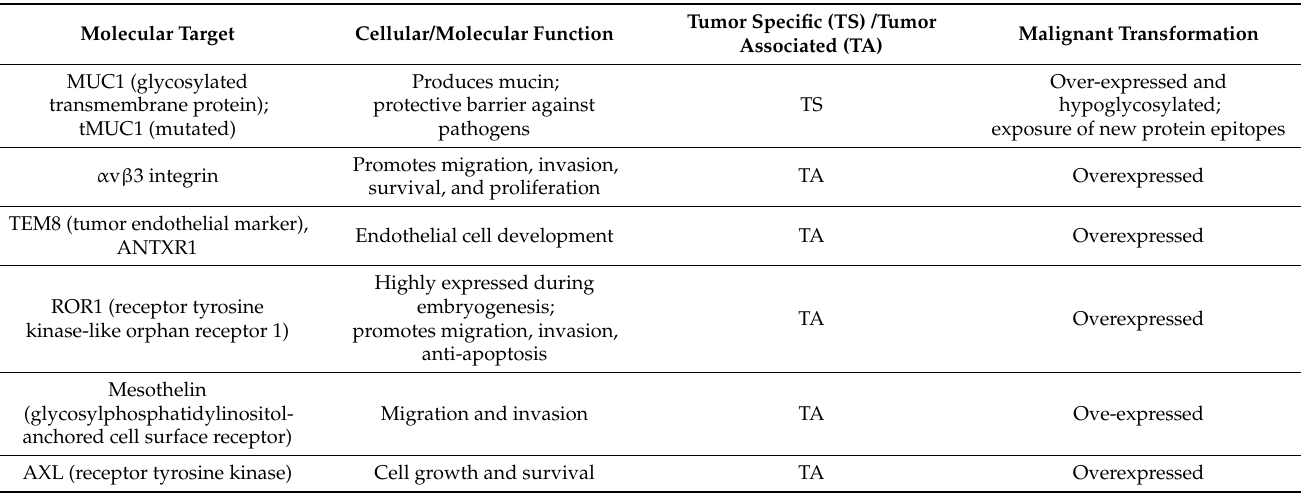
Table 1. Summary of triple-negative breast cancer (TNBC) molecular targets explored by CAR-T cell therapy. Molecular